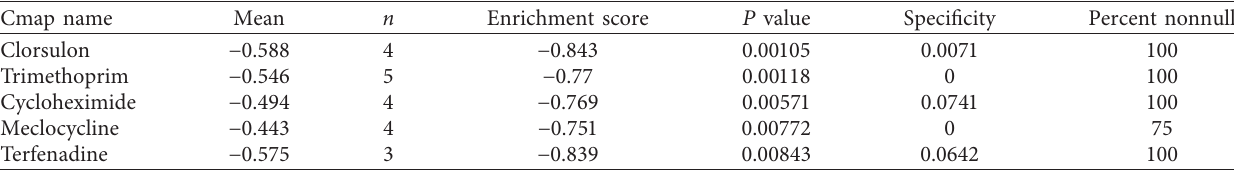
Table 1: The potential small-molecule